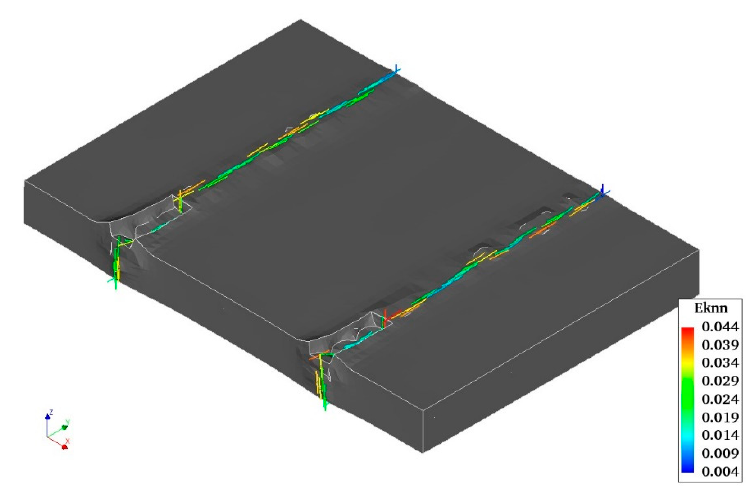
Figure 21. The predicted transverse crack pattern of ARCP-2.